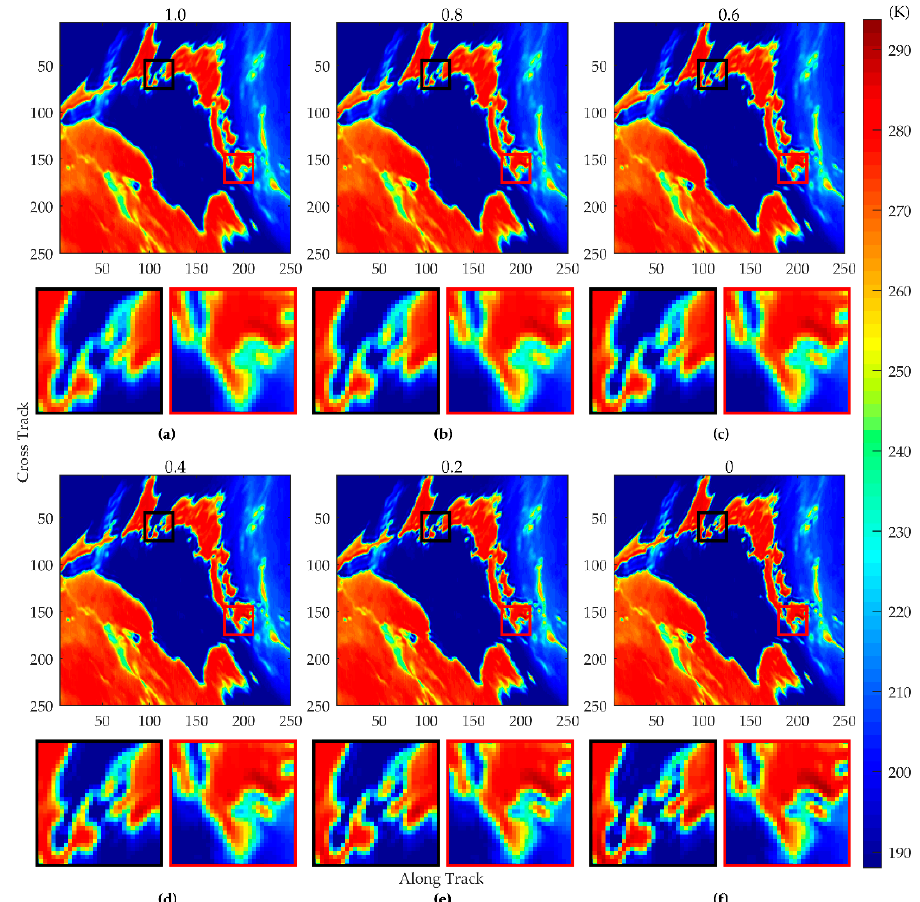
γ N γ . (a) Output of adjustable a a . ( a ) Output of adjustable network